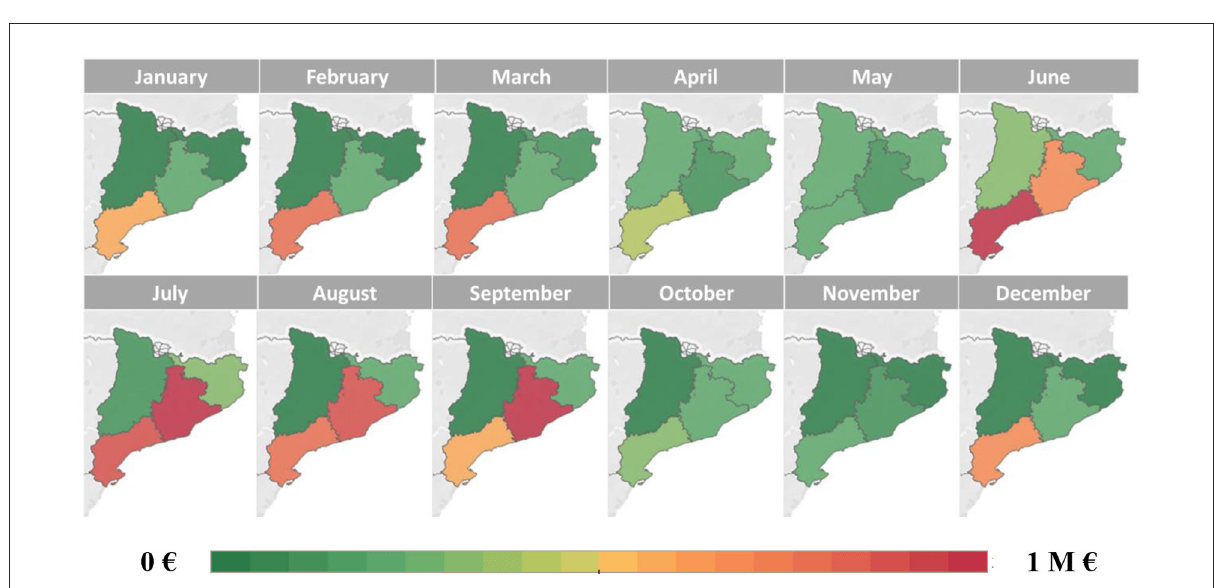
FIGURE4 Spatial and temporal analysis of the economic impact of food loss in Catalonia, calculated as the sum of possibly avoidable food surpluses (PAS) and avoidable food surpluses